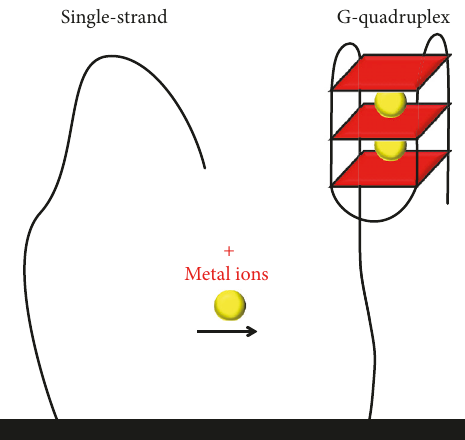
Scheme 3: Folding-based GQ electrochemical biosensor for the detection of metal ions.